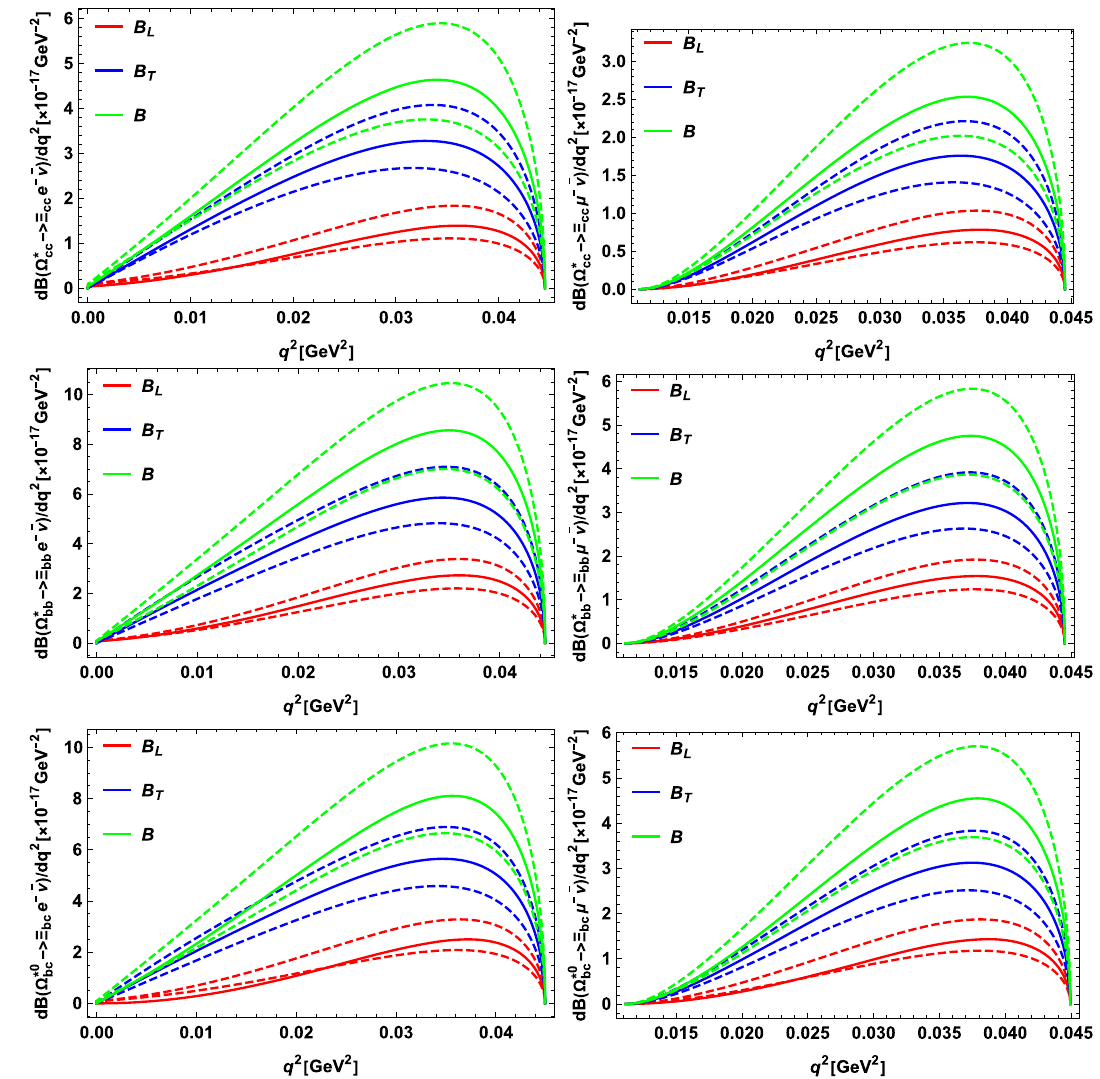
Fig. 5 The differential decay width dB/d q 2 of spin-3/2 to spin-1/2 doubly heavy baryon decay processes. The B L and B T represent the contribution of longitudinal polarisation and transverse polarisation in branching fractions in Eq. (45)